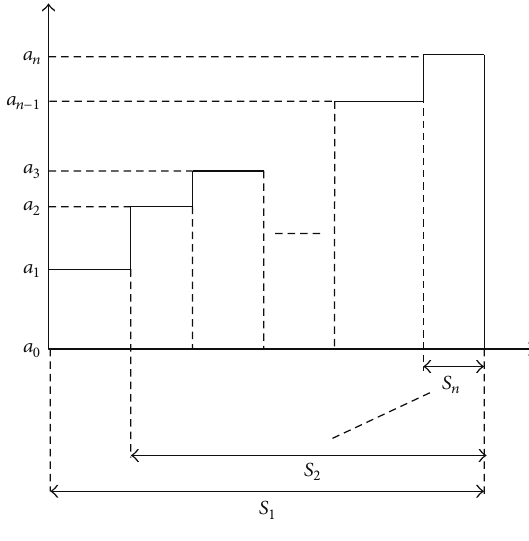
Figure 1: Choquet